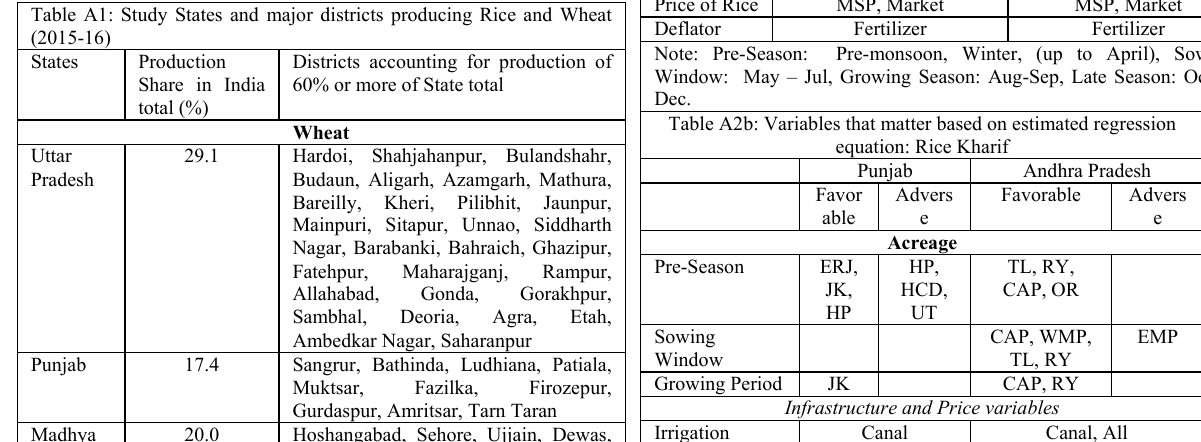
Table A1: Study States and major districts producing Rice and Wheat (2015-16) States